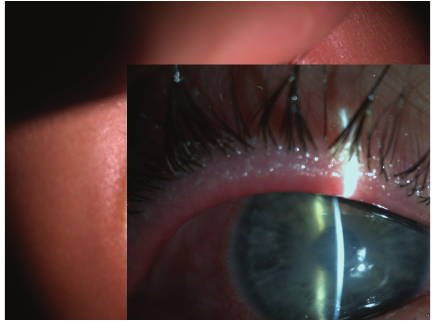
Figure 1: Ring ulcer and stromal necrosis of cornea.